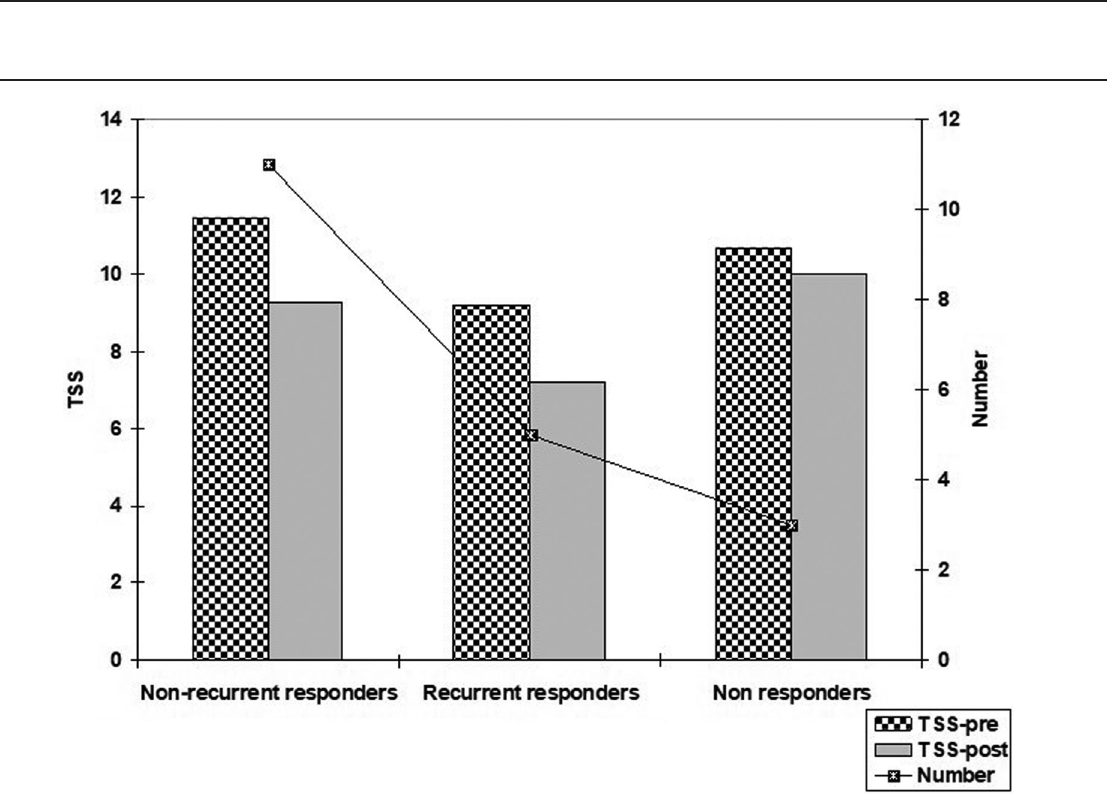
Outcome of patients who received a second session of omalizumab